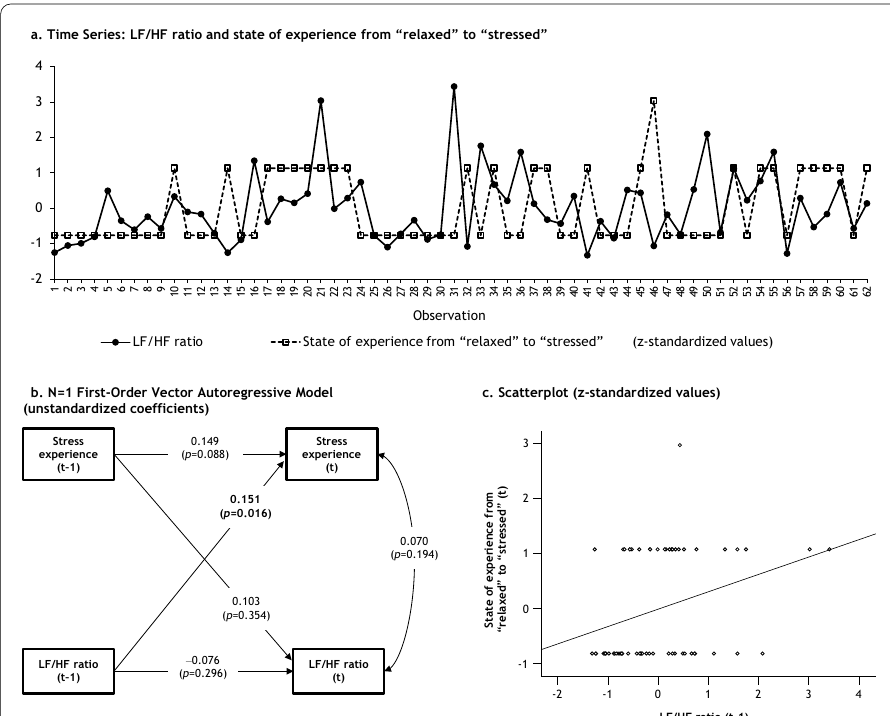
Fig. 4 The LF/HF ratio and state of experience from “relaxed” to